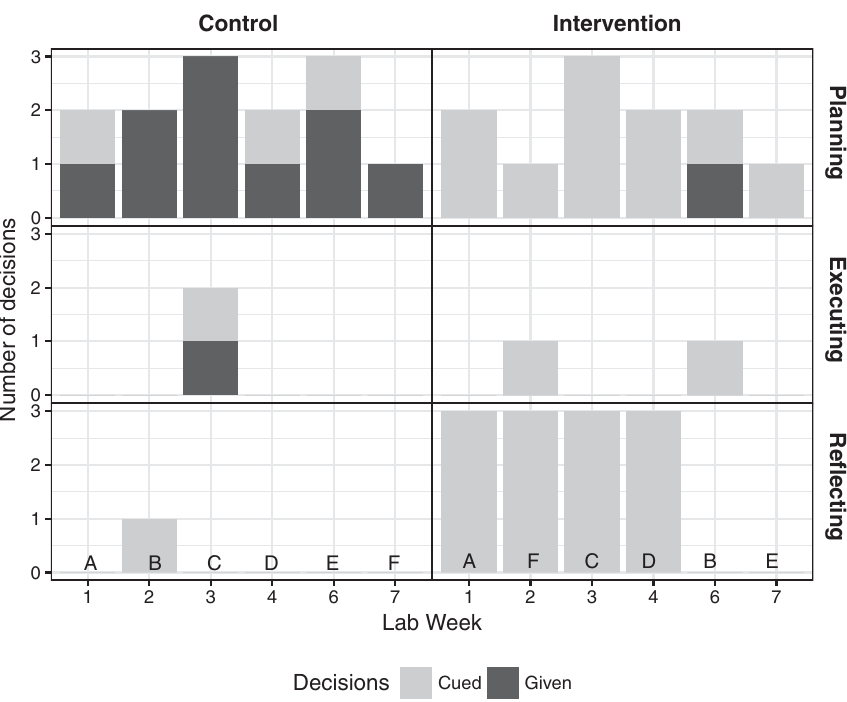
FIG. 3. The number of agency-based decisions provided in the instructions across labs and conditions. The instructions either made decisions for the students (given) or cued students to make decisions (cued). The instructions in the control condition made many planning decisions for the students, but provided little structure for executing and reflecting. The instructions in the intervention condition had more structure overall, but this structure was almost exclusively in the form of cues and the structure was faded over